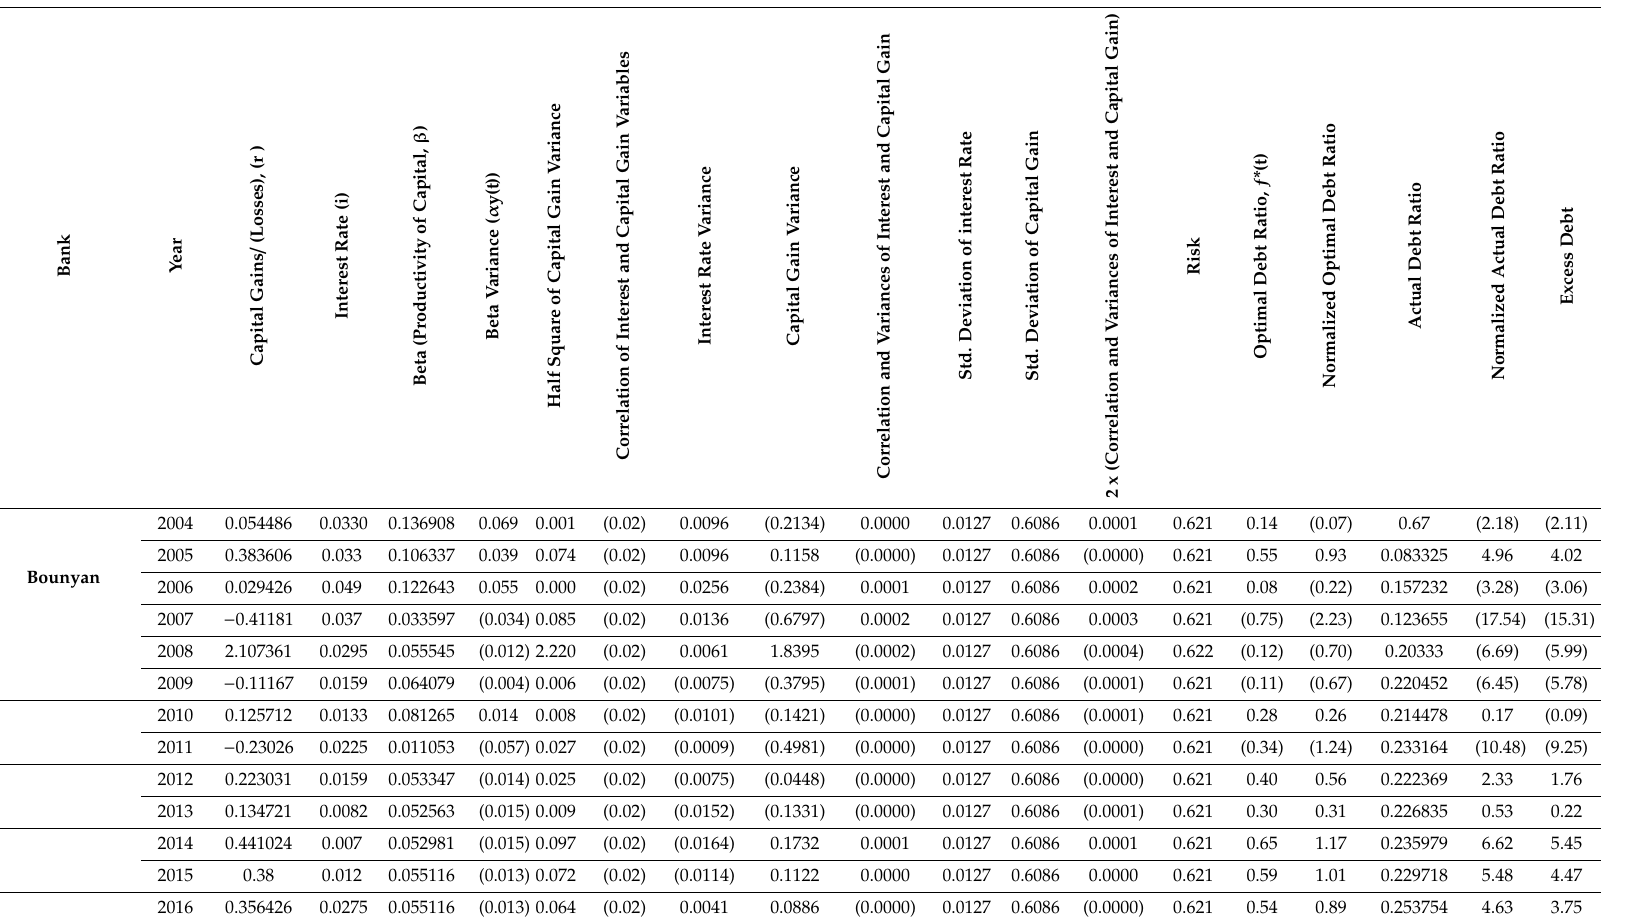
Table A8. Calculations of Optimal and Excess Debt: